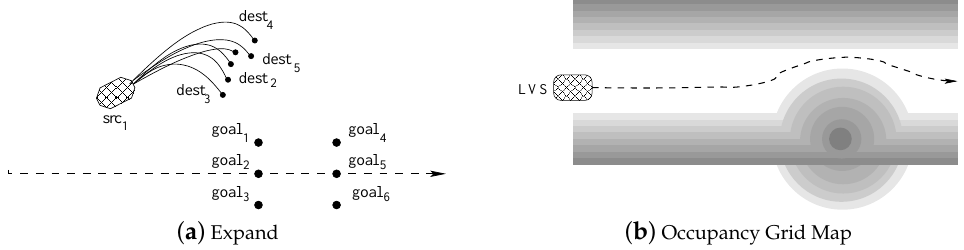
Figure 7. ( a ) shows an example of how procedure E XPAND K ERNEL computes destination points by expanding the recursion tree of one single level. ( b ) shows all generated points (the entire path) within the current occupancy